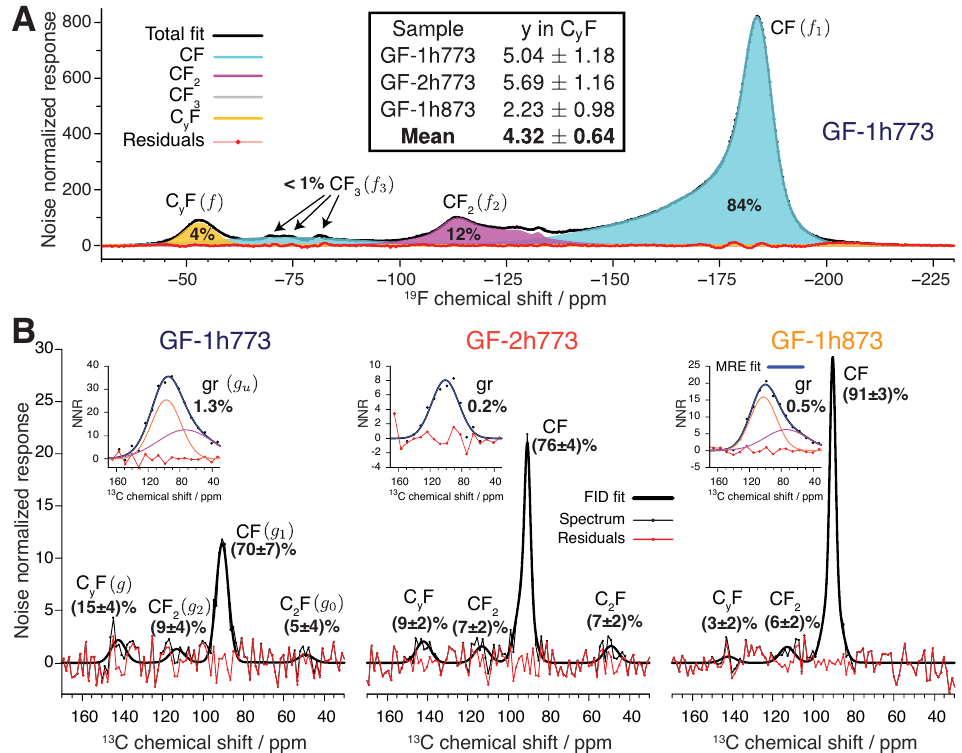
Figure 5. Quantitative analysis of NMR spectra. ( A ) Fit of 1D 19 F centerband NMR spectrum of GF-1h773 into components assigned to C y F ( f ), CF 3 ( f 3 ), CF 2 ( f 2 ), and CF ( f 1 ) units. ( B ) Fit of quantitative 1D 13 C MAS NMR spectra into components assigned to C y F ( g ), CF 2 ( g 2 ), CF ( g 1 ), bridging C ( g 0 ), and unfluorinated carbon ( g u ). The matched reconstructed CPMG echo (MRE) is analyzed jointly with the free induction decay (FID) NMR signal to determine the g u fraction. The